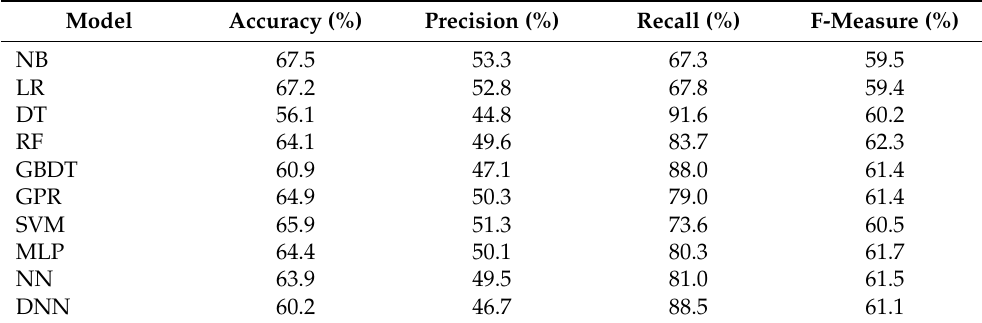
Table 11. Comparison of machine learning models with globe temperature